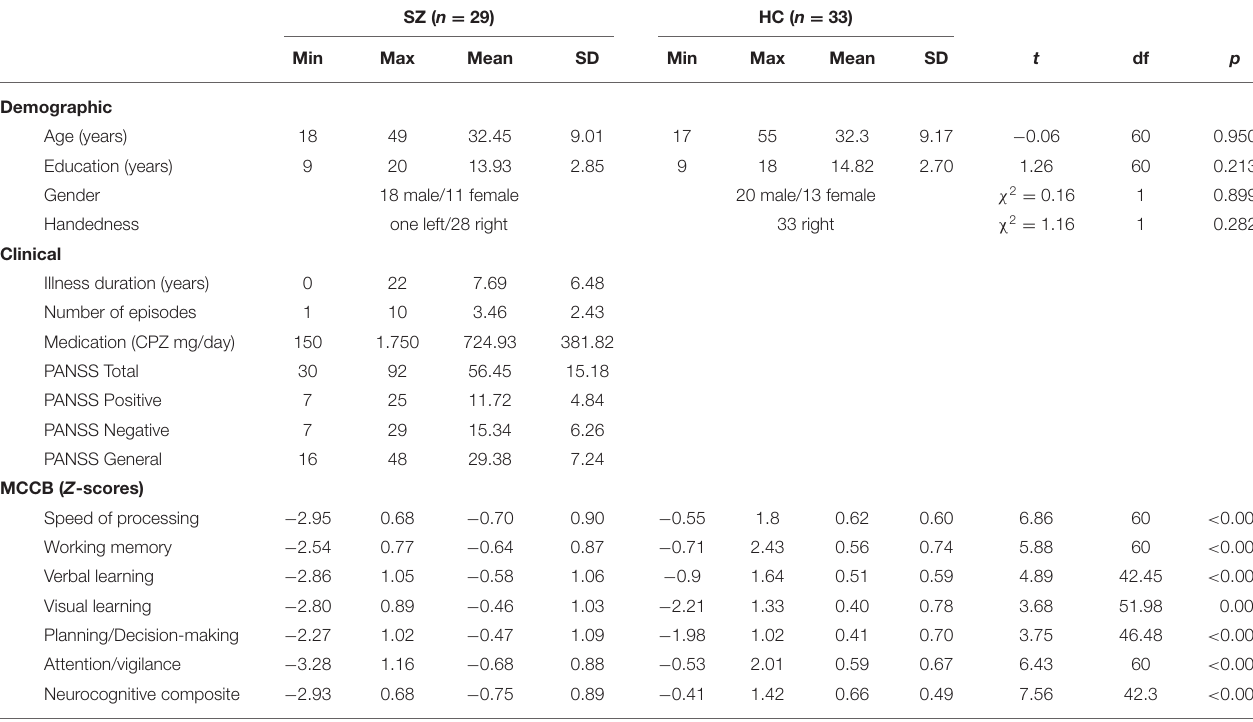
TABLE 2 | Demographical, clinical and neurocognitive characteristics.